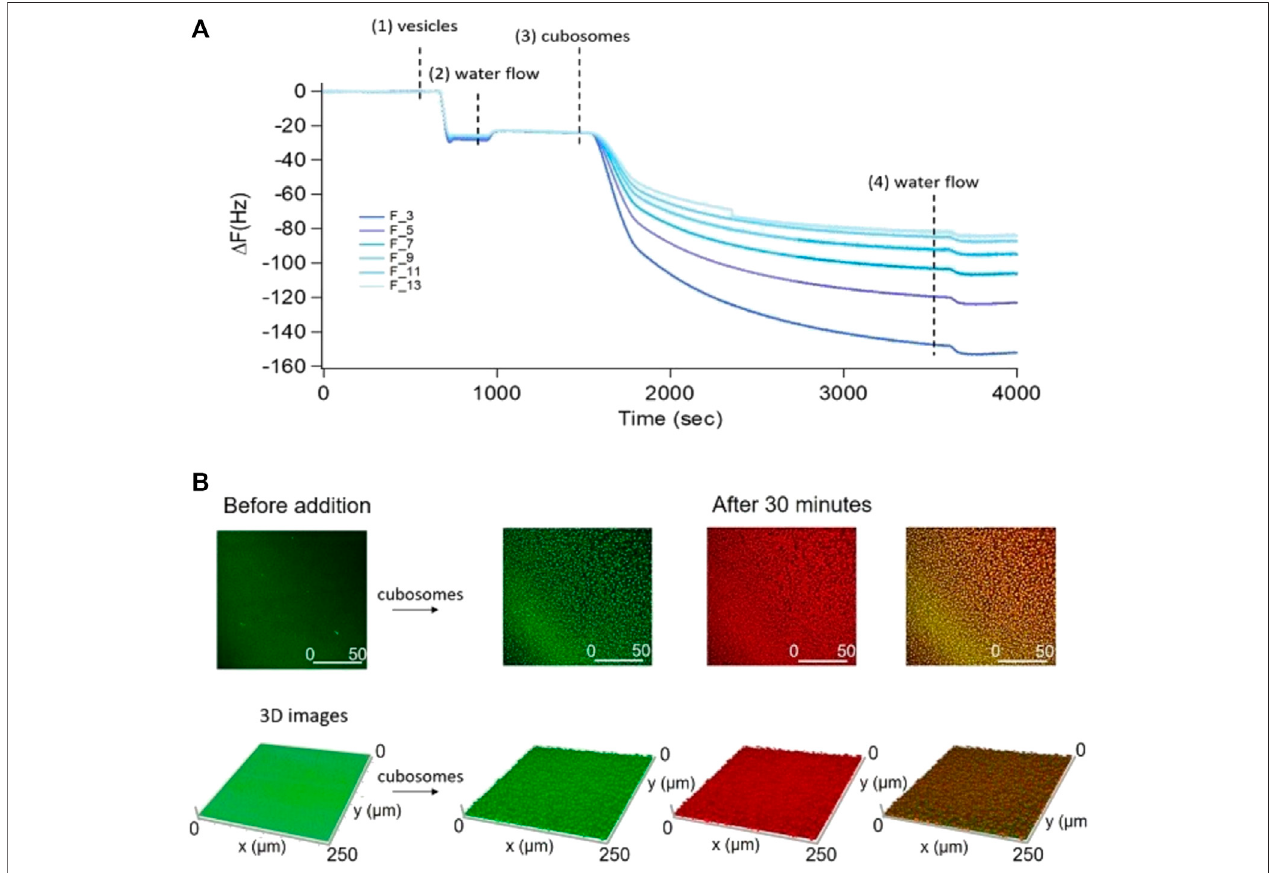
FIGURE3| Panel (A) :QCMexperimentontheadsorptionof4 mg/mlGMO-basedcubosomesonaDOPC/DOTAPSLB.Verticallinesrepresentthesubsequential injection of DOPC/DOTAP vesicles, water, cubosomes, and water (1 – 4). Panel (B) : Representative 2D and 3D Confocal Microscopy images of the cubosomes deposition on the SLB. SLB and cubosomes were fl uorescently labelled with two different probes with well separate emission spectra. Speci fi cally, DOPC/DOTAP liposomeshavebeenlabelledwith β -Bodipy ( λ exc488 nm, λ em493 – 614 nm)whilestabilizer-freeGMO-basedcubosomeswith18:1Cyanine5 PE( λ exc633 nm, λ em 662 – 732 nm). Cubosomes are imaged in red, the SLB in green and the colocalization of the probes in